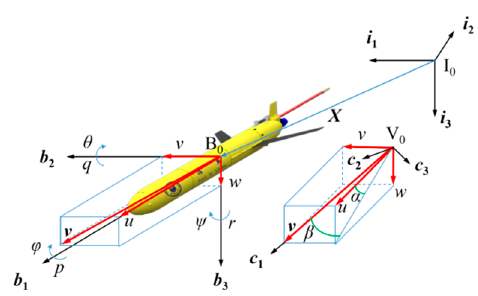
Figure 1. Reference frames and motion parameters of Petrel-II underwater glider.